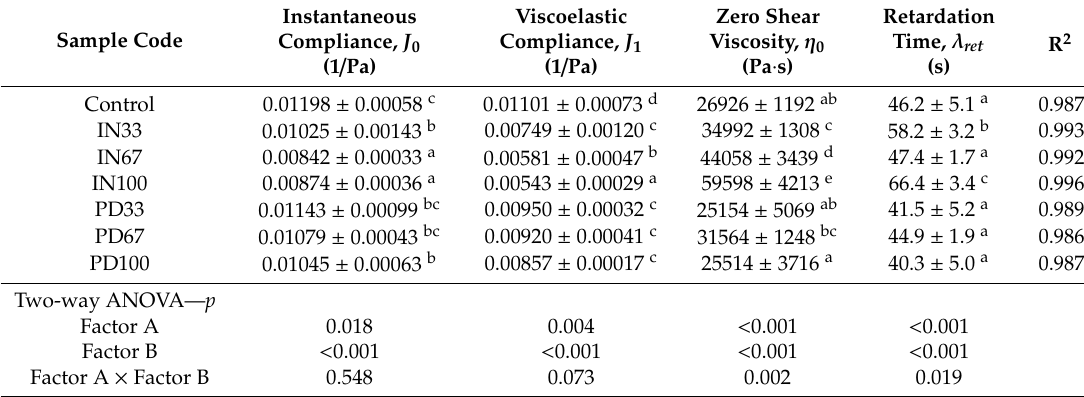
Table 4. Parameters of the Burgers model describing creep and recovery curves of potato starch milk